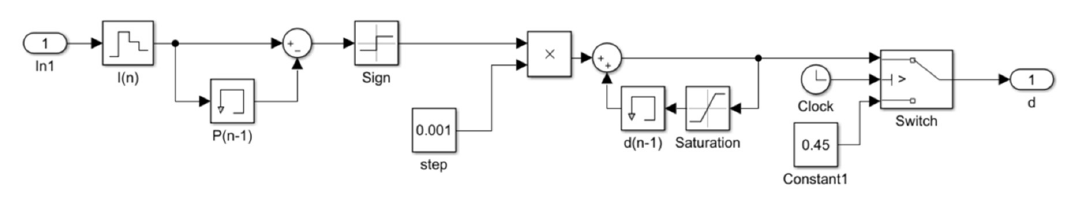
Figure 7. The control flow of the traditional Maximum-Power-Point-Tracking (MPPT) algorithm.